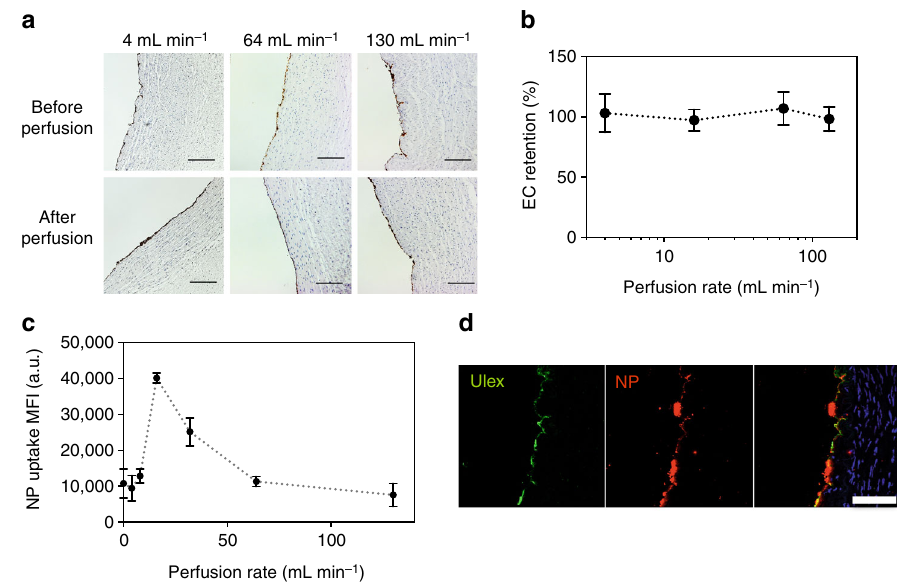
Fig. 4 Perfusion enhances NP uptake by vascular endothelial cells. a Endothelial cell are retained on umbilical veins after perfusion. Veins were perfused with culture media for 6 h using a peristaltic pump (Langer Instruments). After perfusion, vein sections were fi xed in 4% PFA, sectioned, and stained for human CD31 ( scale bar : 200 μ m). b Retention of endothelial cells (ECs), expressed as a %, was calculated from: % EC coverage after perfusion/% of EC coverage before perfusion. c NP ( fl uorescent ) association with umbilical veins after perfusion. Veins were perfused with DiD-NPs (0.1 mg mL − 1 ) at 0 – 130 mL min − 1 . After 6 h, ECs were harvested from the vein and particle-cell association was quanti fi ed using fl ow cytometry. Data shown is mean ± SD. d Confocal image of fl uorescent NPs ( red ) associated with endothelial cells ( green ) on the umbilical vein after perfusion (16 mL min − 1 , 6 h), scale bar : 100 μ